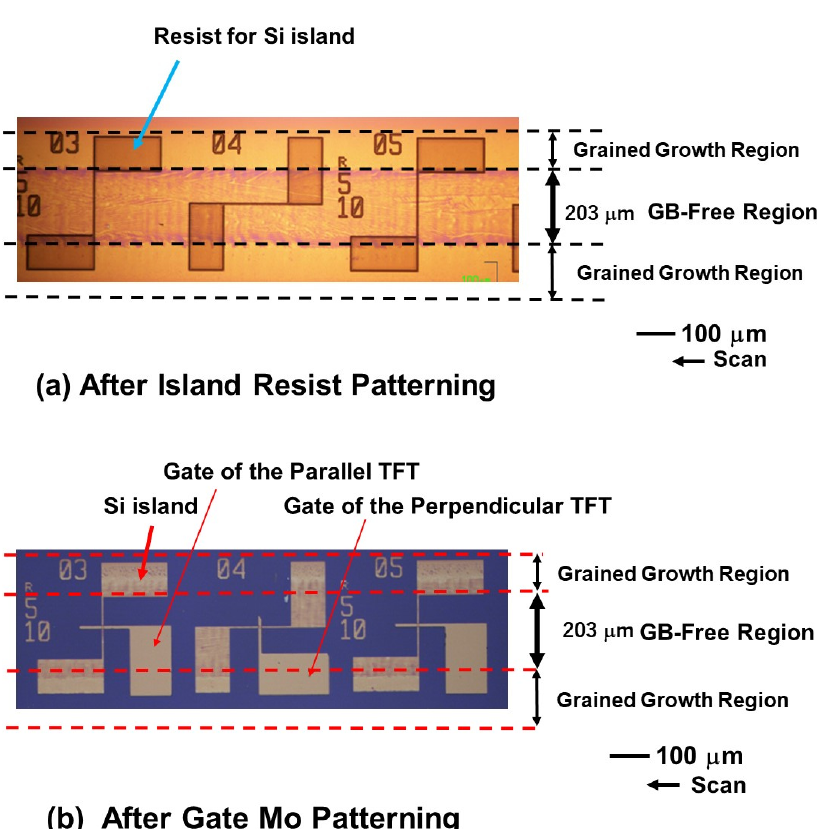
Figure 6. Optical micrograph of the TFT fabrication: ( a ) after the island patterning and ( b ) after the gate patterning. The channel length was 10 µ m with a width of 5 µ m for both parallel and perpendicular TFTs.